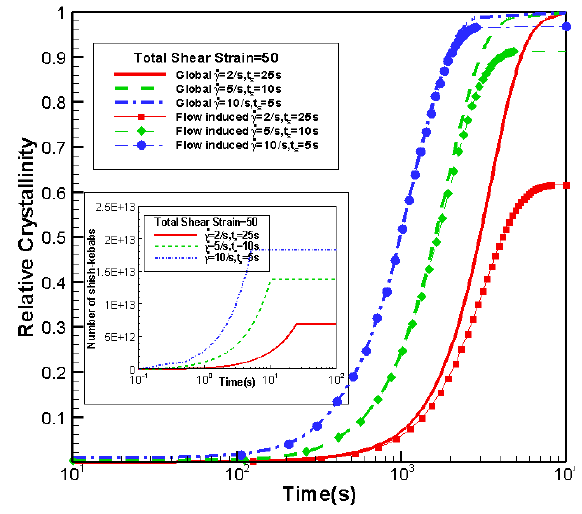
Figure 11. Relative crystallinity comparison with same shear strain but different shear rate and shear